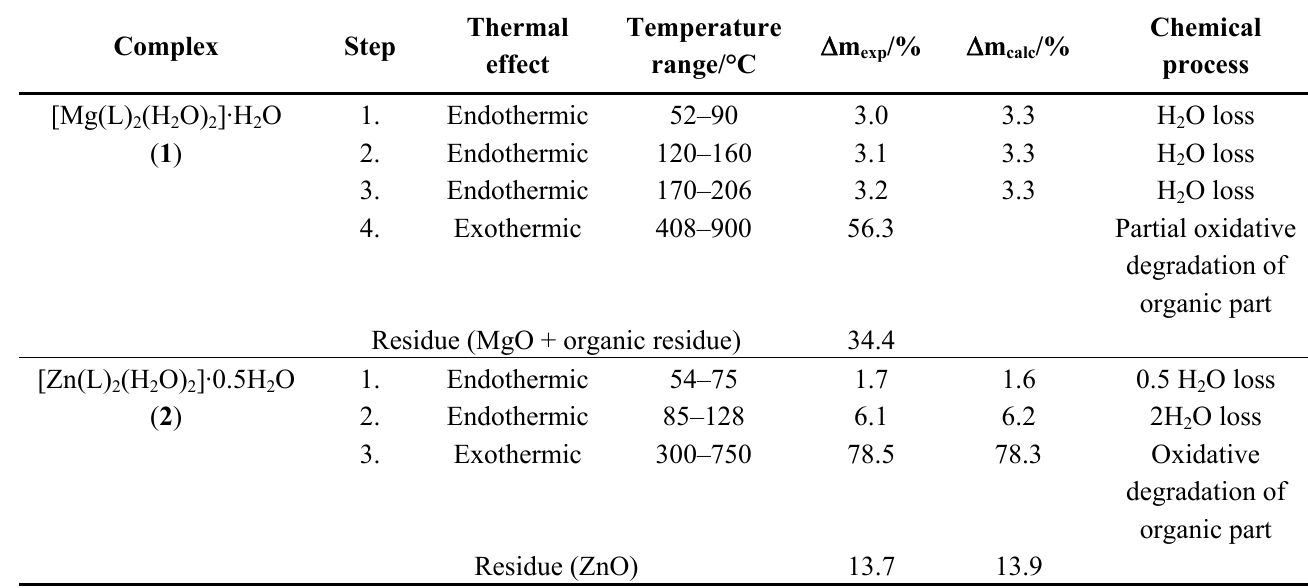
Figure 5. TG and DTA curves of [Mg(L)